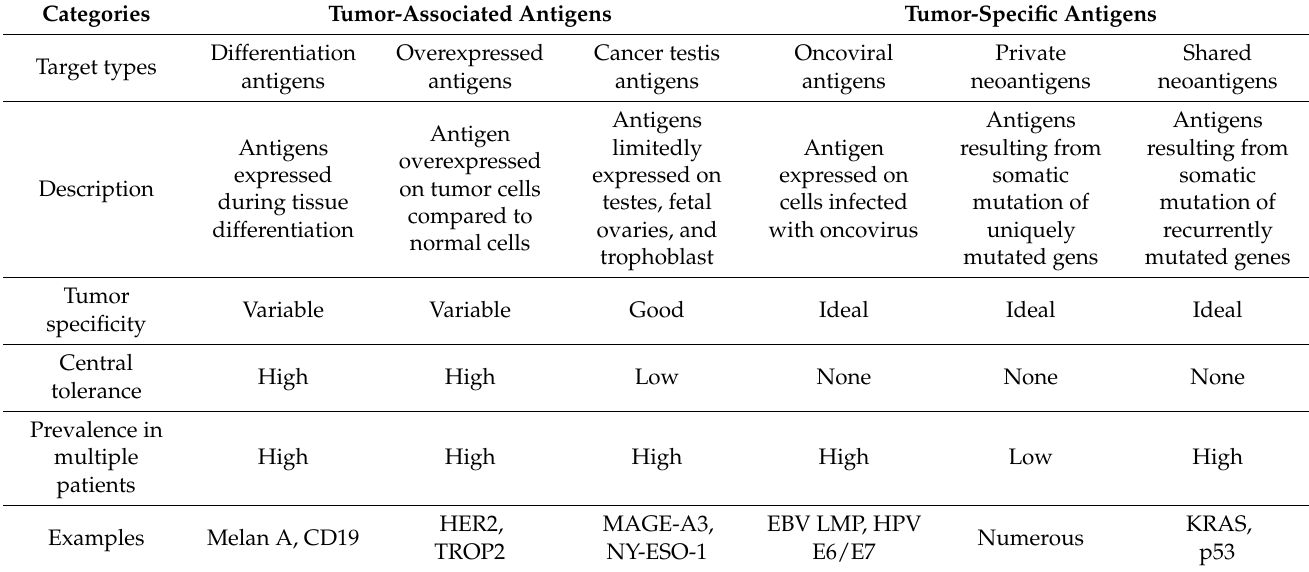
Table 1. Classification of tumor